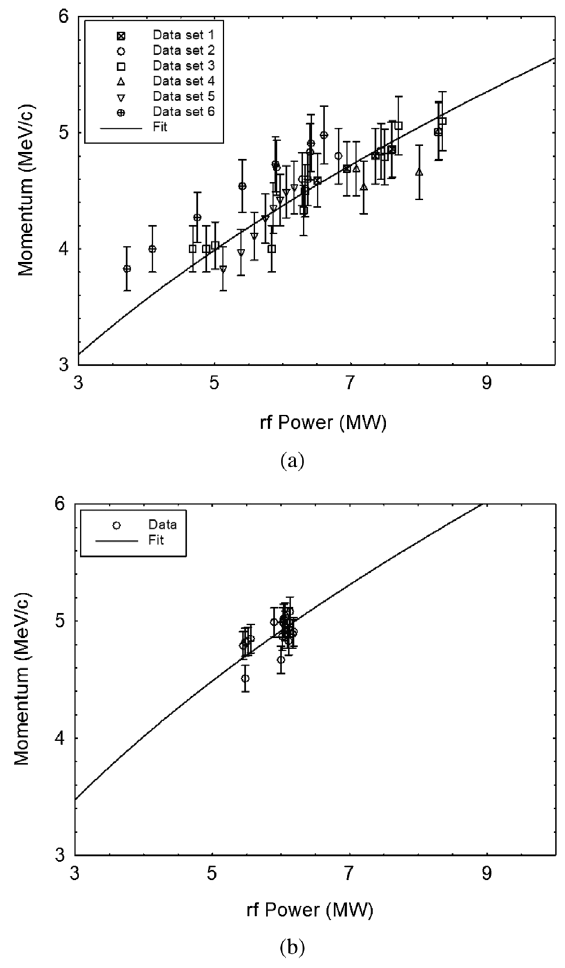
FIG. 32. A comparison of plots of on-crest momentum versus power for the 2.5-cell gun in both (a)VELA and (b) CLARA FE